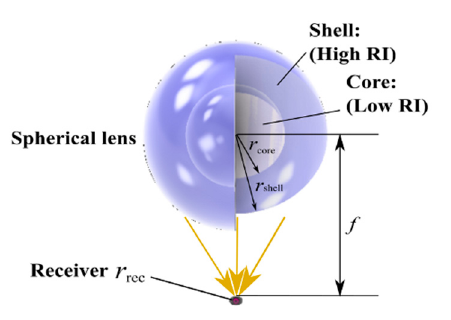
Figure 3. Simulation model of the core-shell spherical (CSSP) lens.